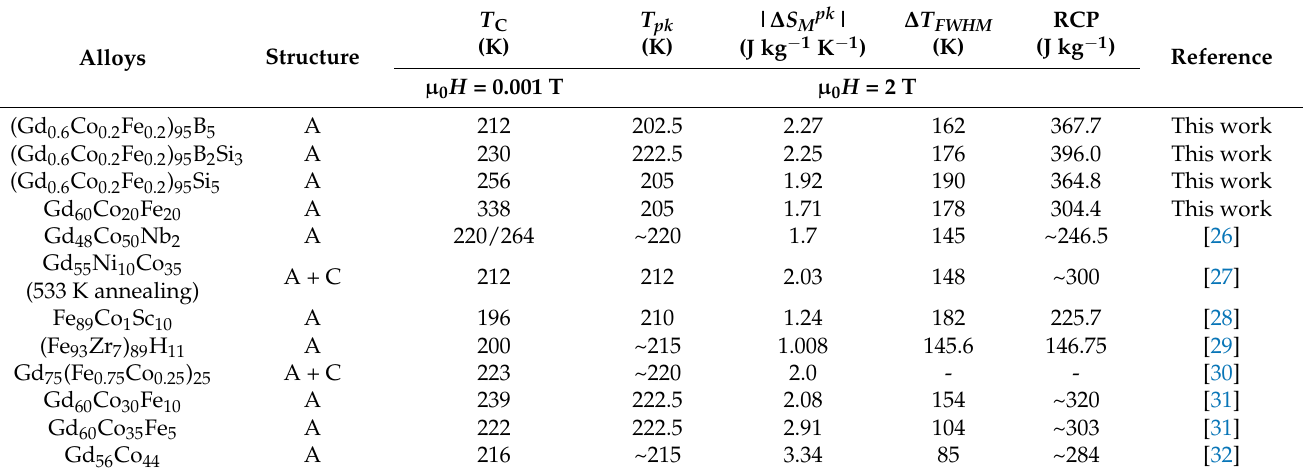
Figure 4. The correlation between magnetic entropy change and temperature of the Gd 60 Co 20 Fe 20 Table 1. Magnetic and magnetocaloric properties of various materials with a similar working temperature range (A and C indicate amorphous and crystalline structures, respectively.)